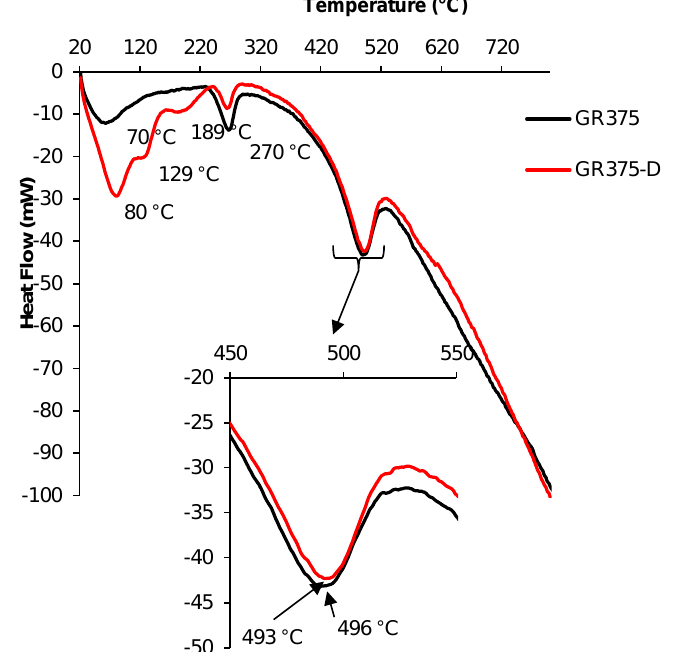
Figure 3. DSC analysis of the raw (GR375) and the DMSO intercalated (GR375-D) kaolinite.